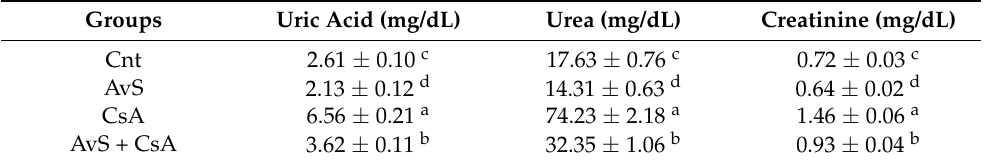
Table 5. Effects of avocado seed powder on the serum levels of kidney function biomarkers in rats.